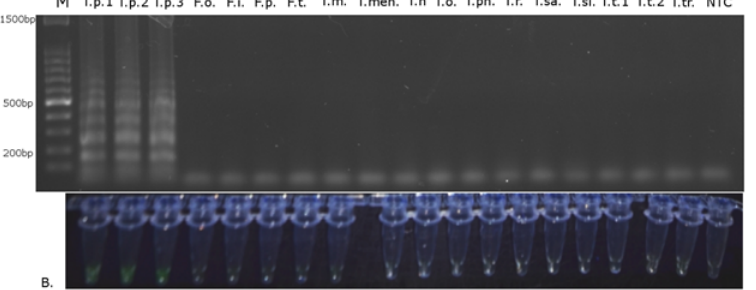
Fig 3. Visualization of LAMP reaction results. A) After electrophoresis in a 1% agarose gel; B) using EvaGreen stain (Biotium). T.p. — T . palmi , F.o. — F . occidentalis , F.i. — F . intonsa , F.p. — F . pallida , F.t. — F . tenuicornis , T.m. — T . major , T.men. — T . menyanthidis , T.n. — T . nigropilosus , T.o. — T . origani , T.ph. — T . physapus , T.r. — T . roepkei , T.si. — T . simplex , T.sm. — T . sambuci , T.t. — T . tabaci , T.tr. — T . trehernei , NTC — no template control.